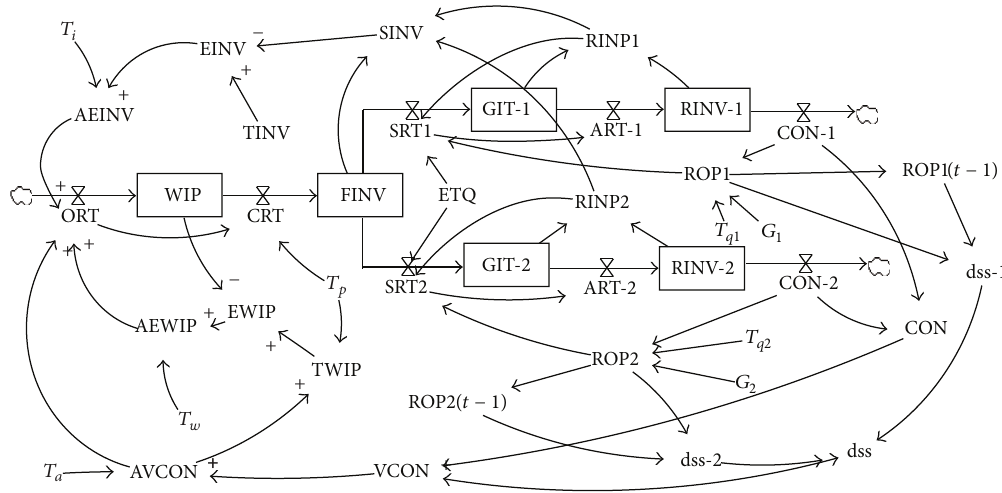
Figure 7: VMI-APIOBPCS II system dynamics